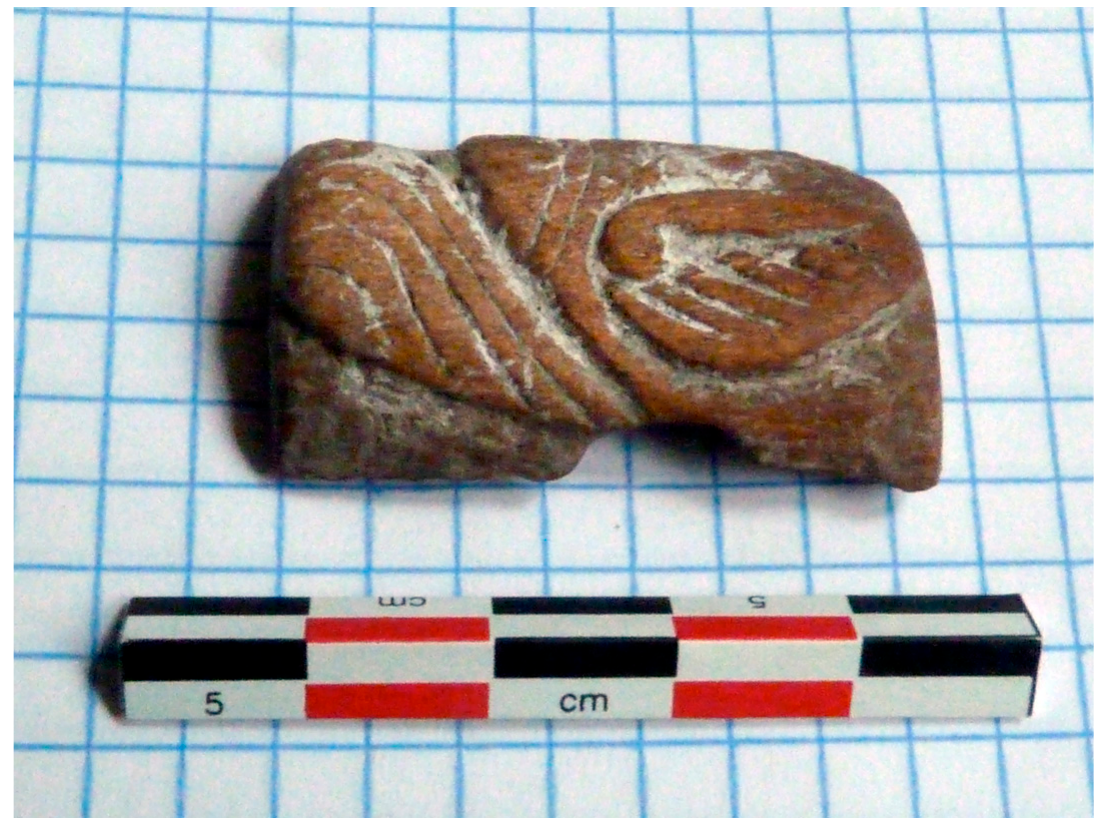
Figure 5. Animal-style bone plaque from Tuzusai.